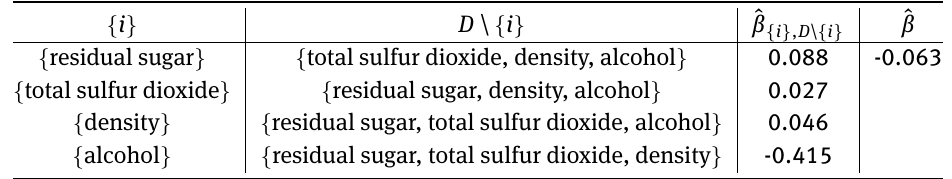
Table 2: Estimates of the bivariate coefficients β { i } , D \ { i } and of the multivariate medial correlation coefficient β for the vari- ables residual sugar , total sulfur dioxide , density and alcohol within the wine